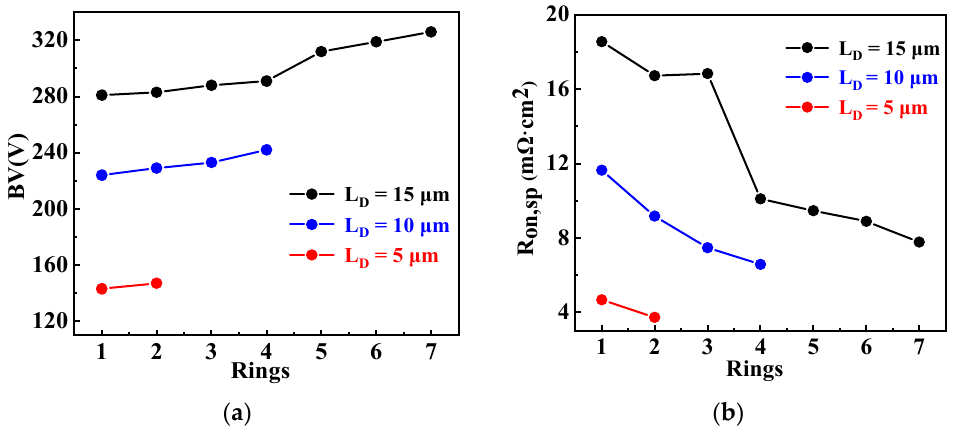
Figure 4. Dependences of ( a ) BV and ( b ) R on,sp on Rings values and L D for S-FLI VDMOS.